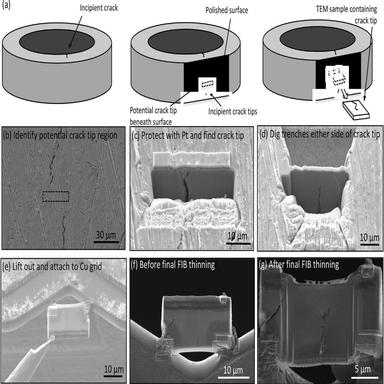
(a) Schematic of TEM sample preparation route for irradiated tested samples, (b)e(g) FIB-SEM images of TEM sample preparation route.